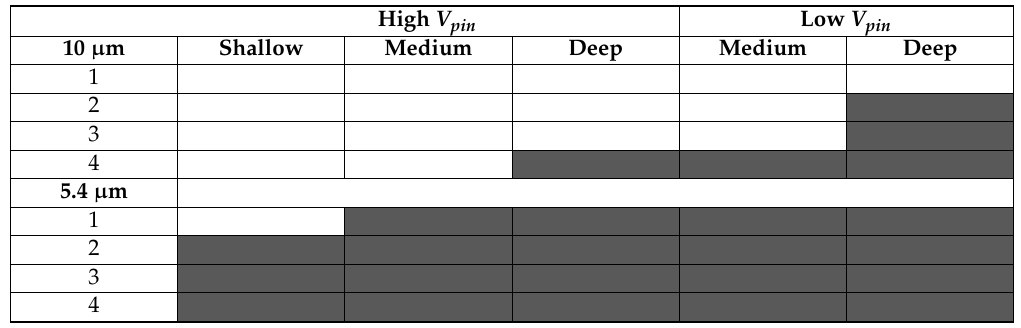
Table 2. Pixel variants in which full well capacity (FWC) limiting has been observed are indicated by a gray-filled